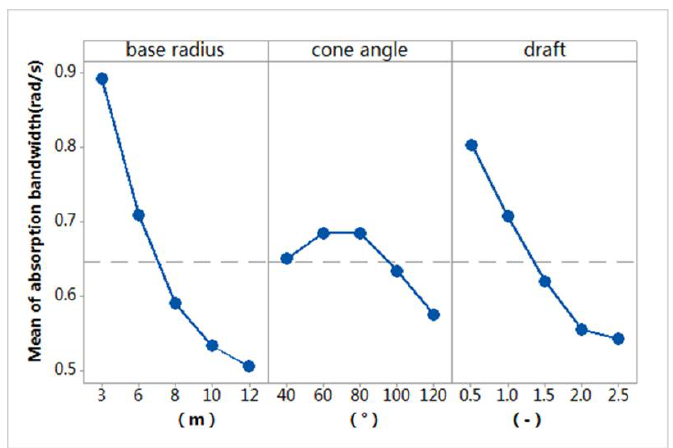
Figure 8. Main effects diagram for absorption bandwidth.